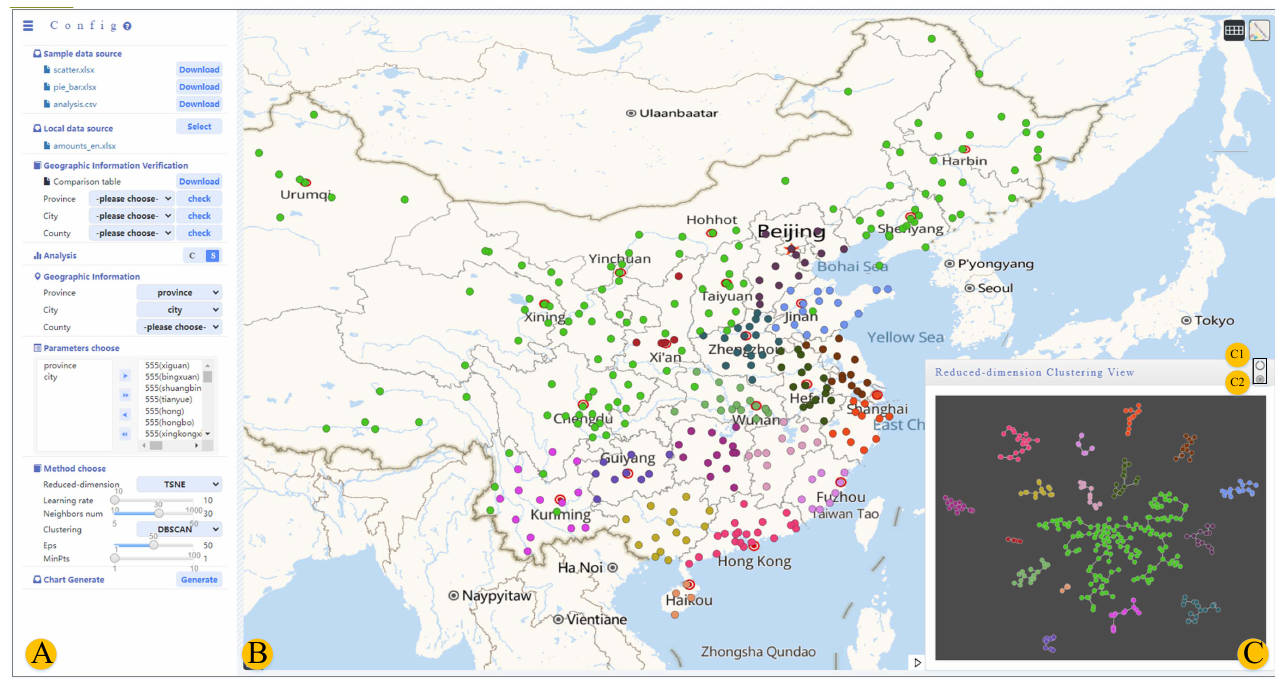
Figure 4. Data similarity interaction analysis. ( A ) Configuration panel. ( B ) Map view of spatial distribution features of data. ( C ) Analysis of reduced-dimension clustering view of the similarity distribution of tobacco high-dimensional data in the geographical space. ( C1 ) is the lasso tool and ( C2 ) is the contour